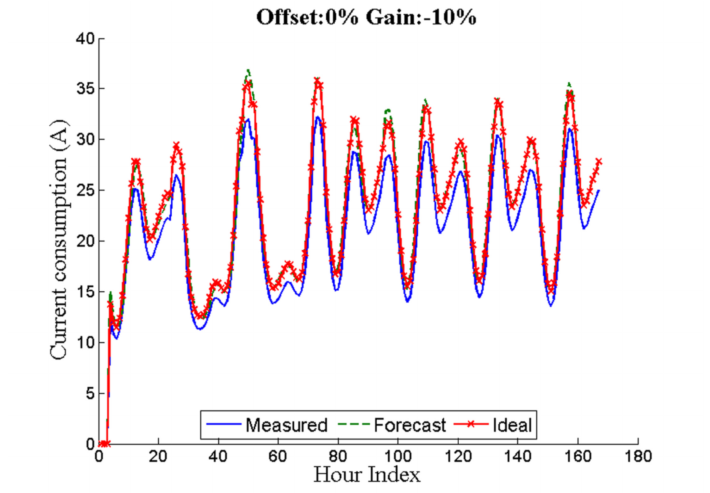
Figure 5. Seven days with a gain error of −